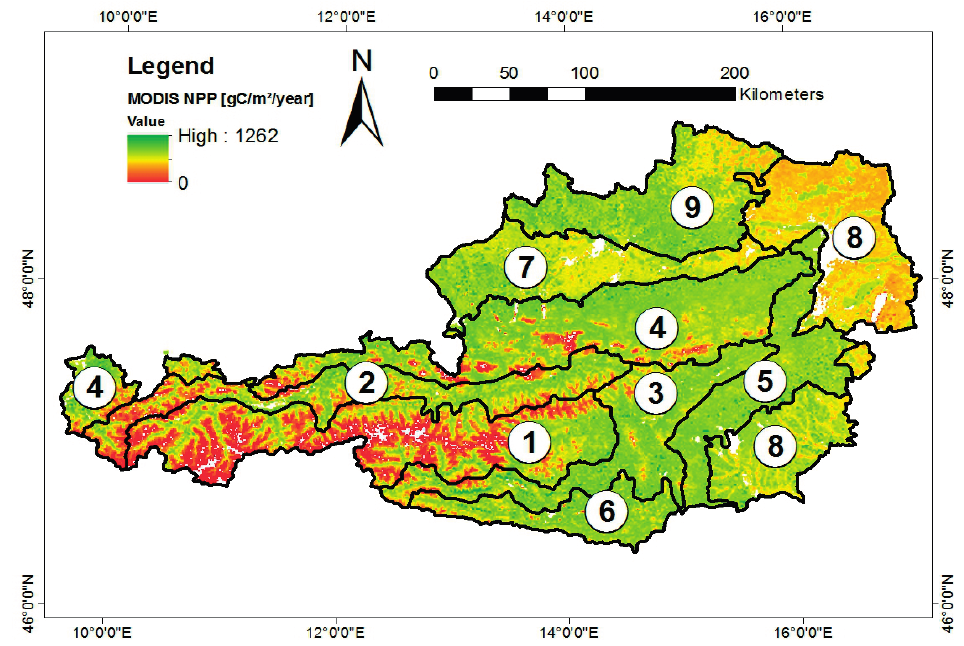
Figure 1. MODIS NPP for Austria calculated with NCEP2-climate data, black lines delineate forest ecoregions [31] used in the